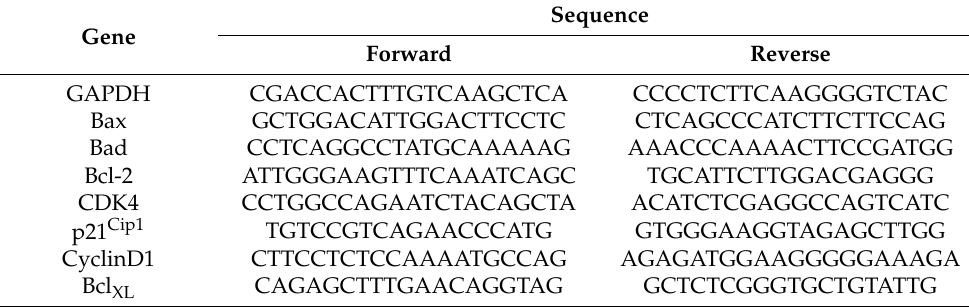
Table 1. RT-PCR primers list.